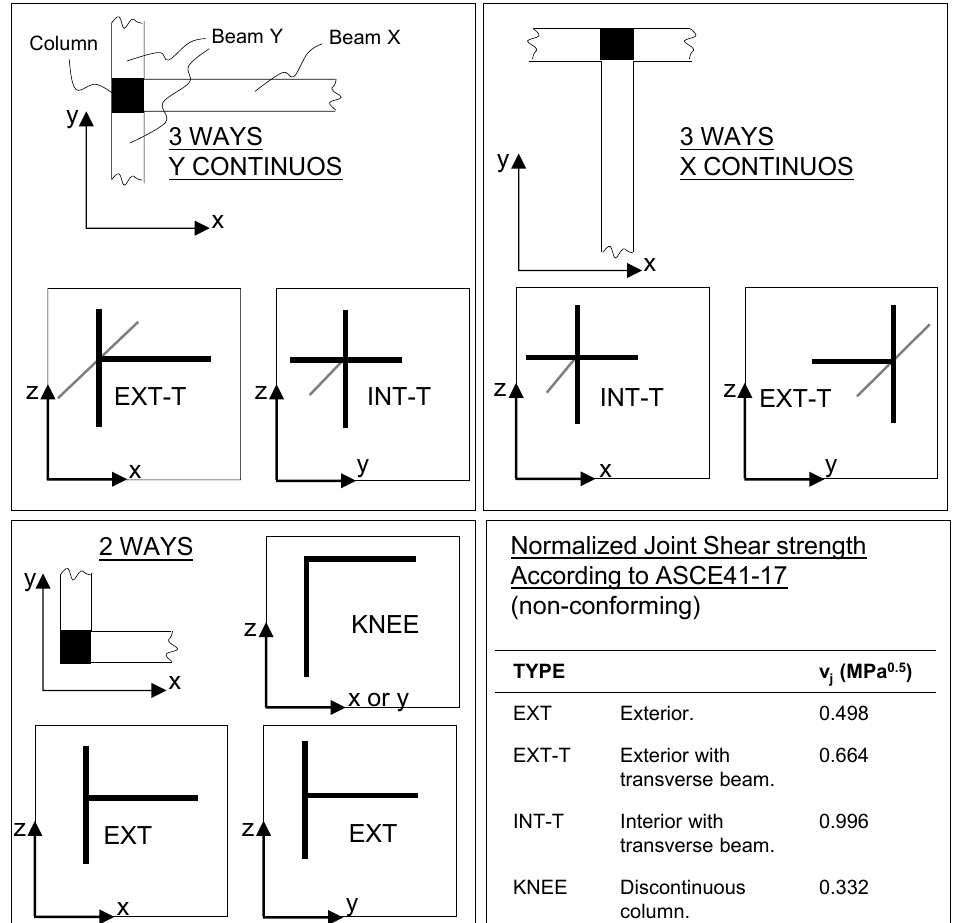
Figure 5. Beam–column classification according to ASCE41-17